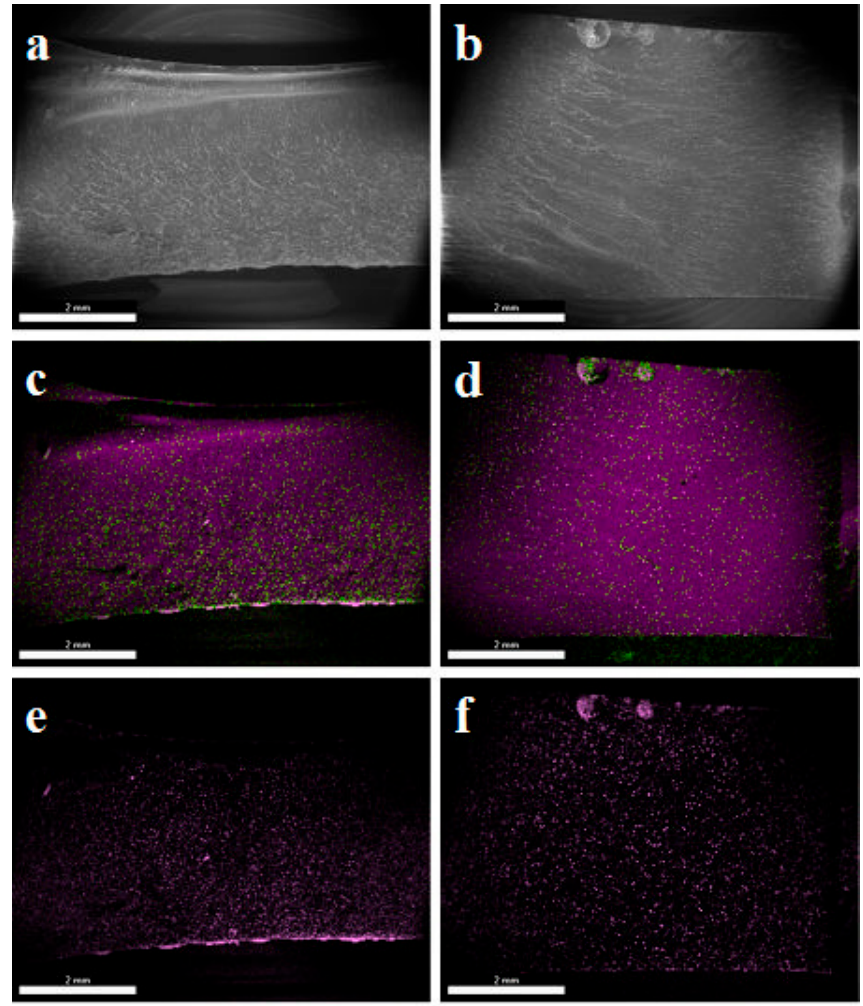
Figure 2. SEM/EDS images of diatoms/resin composites; ( a , c , e )—image of a composite cast in a silicone mould. ( b , d , f )—SEM image of a composite cast in a glass mould.